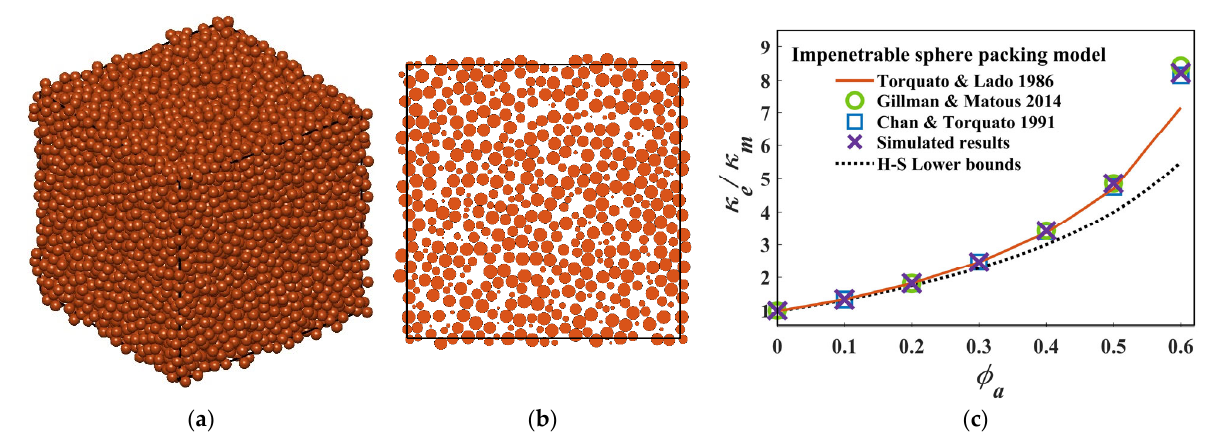
Figure 6. ( a ) An impenetrable sphere packing system, with a packing fraction 𝜙 (cid:3028) (cid:3404) 0.6 ; ( b ) a section of the packing system; ( c ) comparison of the results of normalized thermal conductivity of third ‐ c ) comparison of the results of normalized thermal conductivity of third-order order approximation for impenetrable sphere packing systems 𝜙 (cid:3028) (cid:3404) 0.1 (cid:3398) 0.6 . [8,15,17,20] of the packing system; ( approximation for impenetrable sphere packing systems φ a = 0.1 − 0.6 [8,15,17,20].